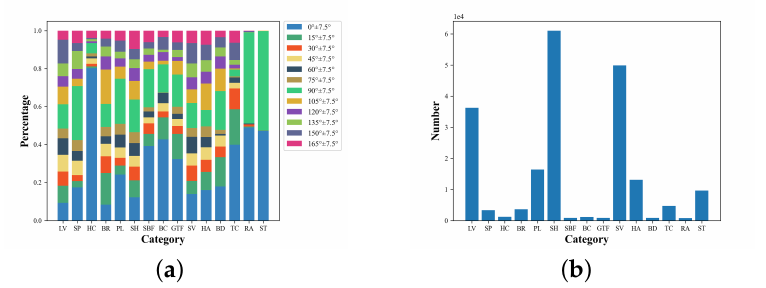
Figure 8. ( a ) The direct distribution of each category in the DOTA-V1.0 dataset by cropping the images at each angle. ( b ) The number of samples in each category after cropping the images in the DOTA-V1.0